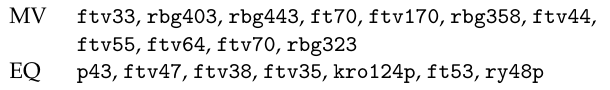
Table 5. Instances for which the Mann Whitney U test supports that there is a significant difference in hypervolume between Multiverse and Multistart Ant Colony Optimization in favor of Multiverse (MV) or no difference (EQ). There is no instance so that there is a difference in favor of Multistart.